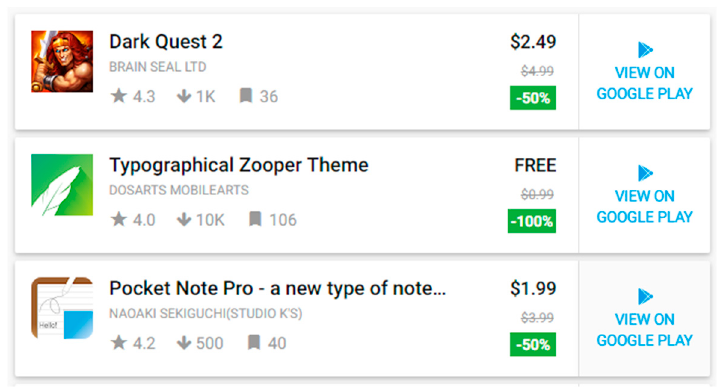
Figure 1. Discounted Apps https://www.app-sales.net.